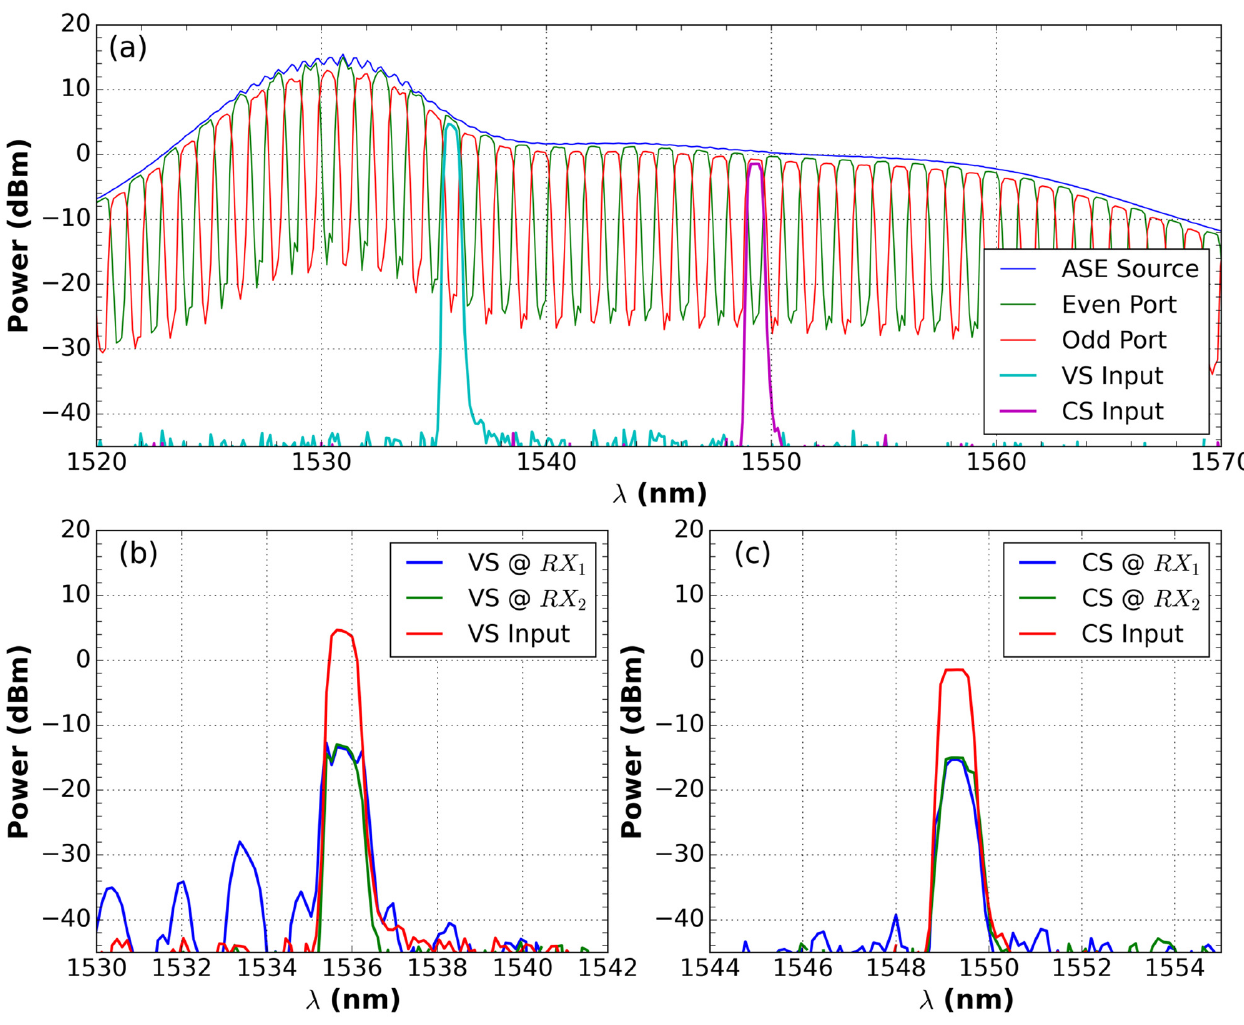
Figure 3. ( a ) Signal spectrum of the ASE light source at the interleaver input, the “Even” and “Odd” ports of the interleaver device, and the signals from the current and voltage sensor inputs, separated by Add/Drop. In addition, ( b ) the spectrum of the input of the voltage sensor (VS) and signals of the VS @ RX after passing through DEMUX; ( c ) the spectrum of the input of the current sensor (CS) and signals of the CS @ RX after passing through DEMUX.